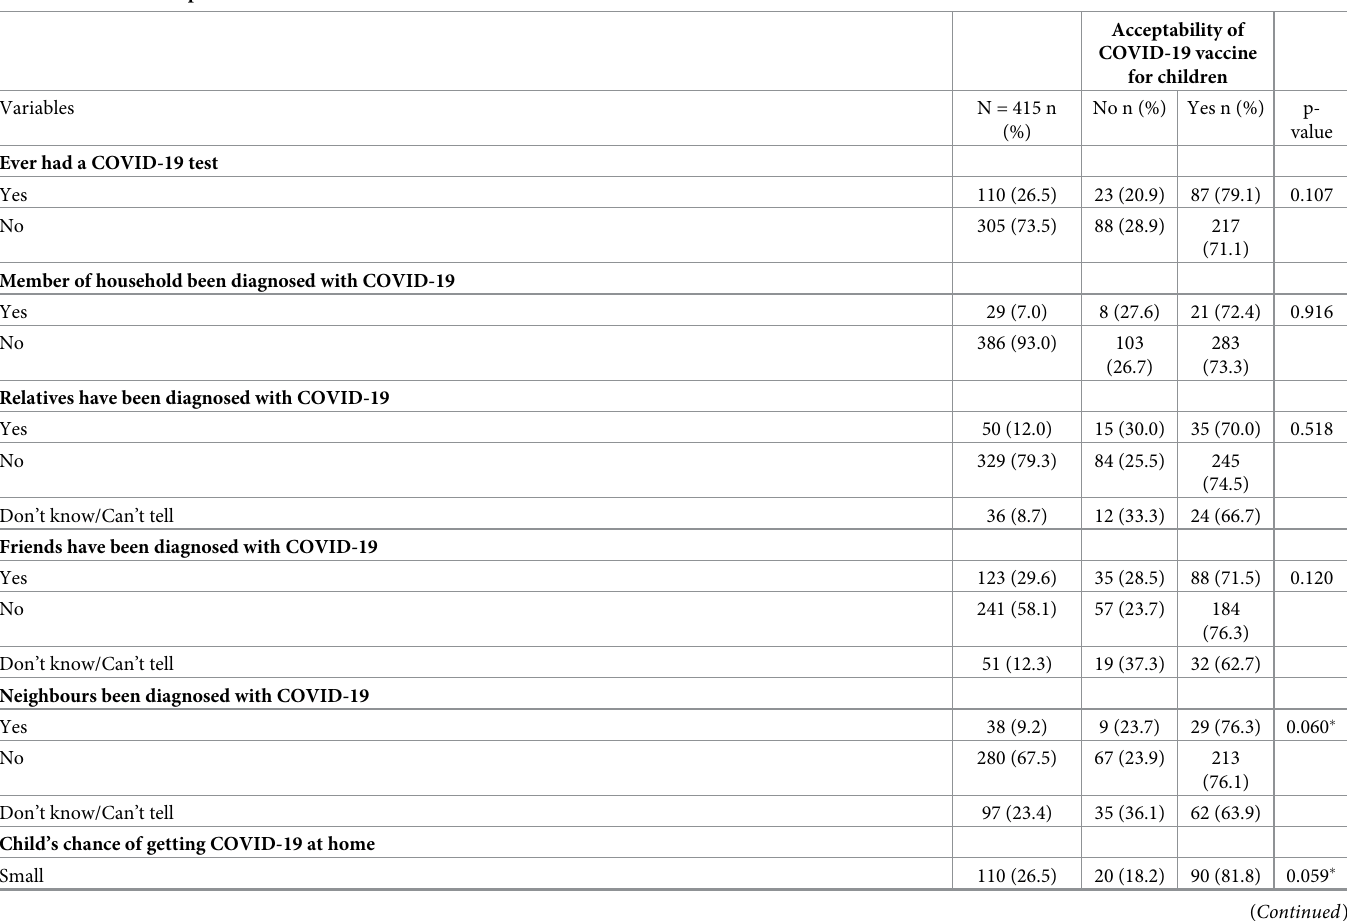
Table 3. COVID-19